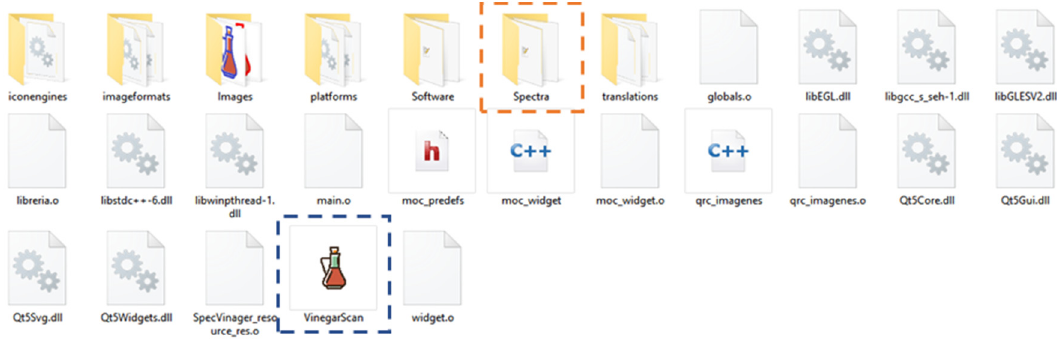
Figure 4. Folders and files present in the computer location “C://VinegarScan” after successfully installing the software. The VinegarScan GUI involves a single main window consisting of three buttons: Load, Start, and Exit (Figure 5). As can be seen in Figure 5, when the user runs the software for the first time, only the Load and the Exit buttons are available.